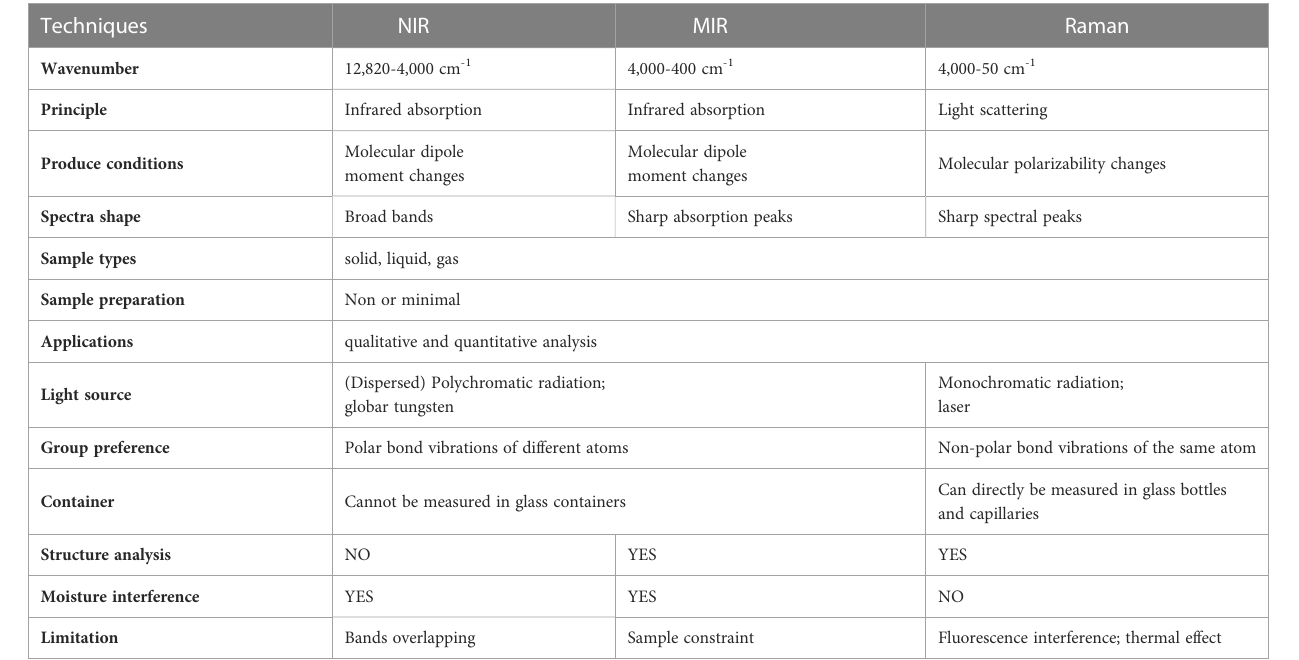
TABLE 1 Comparison of IR and Raman